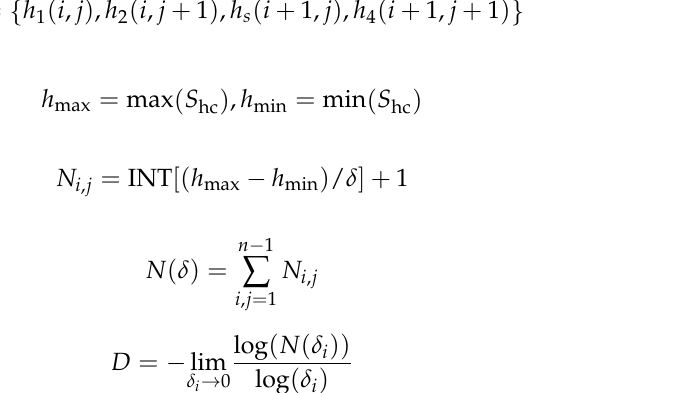
Figure 15. Effect of fault gouge type on cohesion and friction angle. ( a ) is the relationship between cohesion and fault gouge type; ( b ) is the relationship between friction angle and fault gouge type.